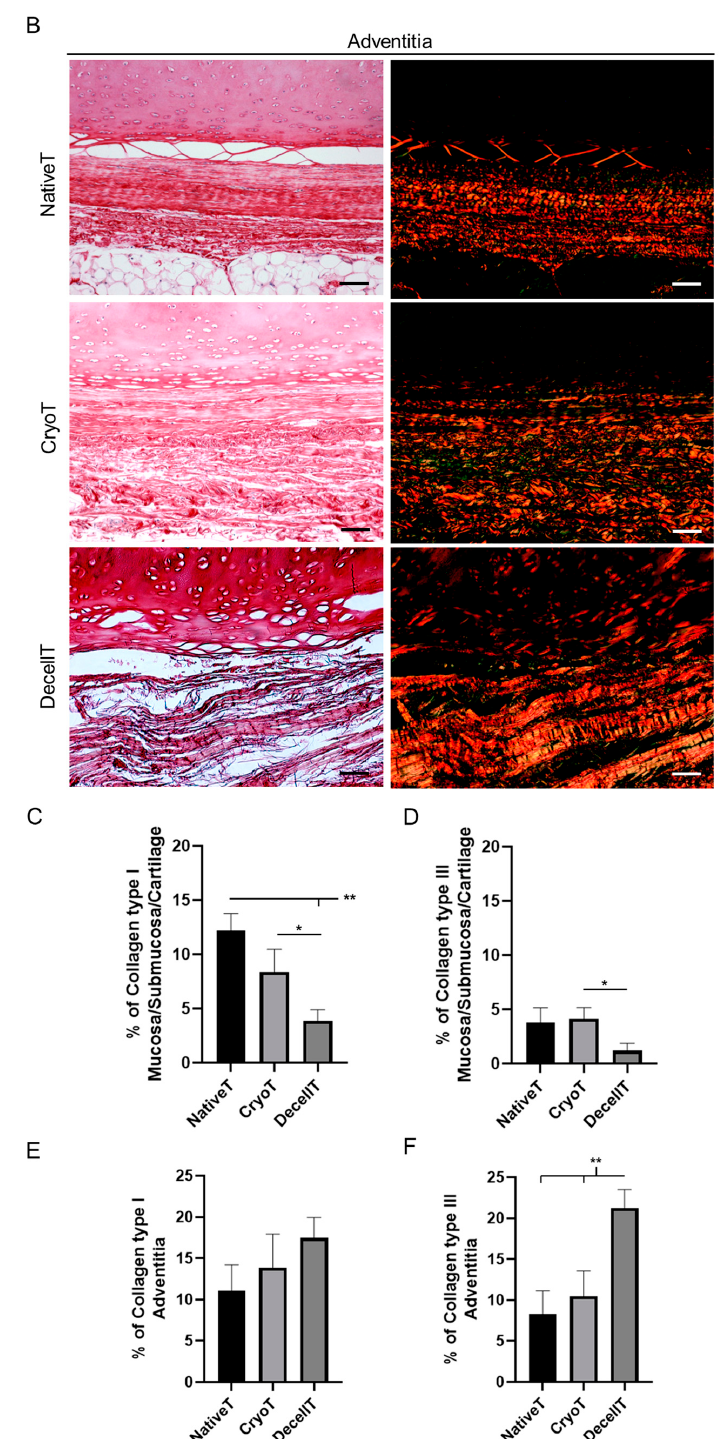
Figure 7. Histological appearance of pig tracheas obtained by cryopreservation (CryoT) and decellularization (DecellT) compared with native tracheas (NativeT) showed by Picrosirius Red staining and visualized under optical microscope (left column) and optical microscope in polarized light (right column). Taking advantage from bifringence, type I or type III collagen fibers were detected appearing as red-orange or green-yellow, respectively. The whole tissue thickness was analyzed: ( A ) mucosa/submucosa and cartilage; scale bars: 50 µ m; ( B ) adventitia; scale bars = 100 µ m. Quan- tification of collagen type I and type III within ( C , D ) the mucosa/submucosa/cartilage and ( E , F ) the adventitia (*: p < 0.05; **: p <